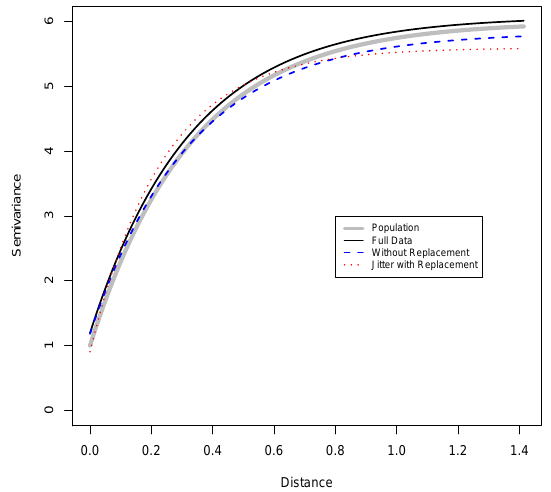
Figure A2. Parametric Semivariograms for Population Process and Three Treatments. Altogether, a few lessons are to be learned. First, if an analyst’s goal is not prediction but efficient inference regarding predictors of interest, either bootstrap will do well. For both β 1 and β 2 , the average deviation from the true population parameters was small for both bootstrap methods, and the credible intervals included the true population parameters more often even than the full-data model. Hence, bootstrapping is a valid choice for inference. Second, if an analyst is particularly interested in the values of the variance terms—as he or she would be if using kriging methods to make predictions—then all three semivariograms look similar. Overall, then, both bootstrap techniques, in cases of big data, can serve as a fair approximation when estimation over full data is